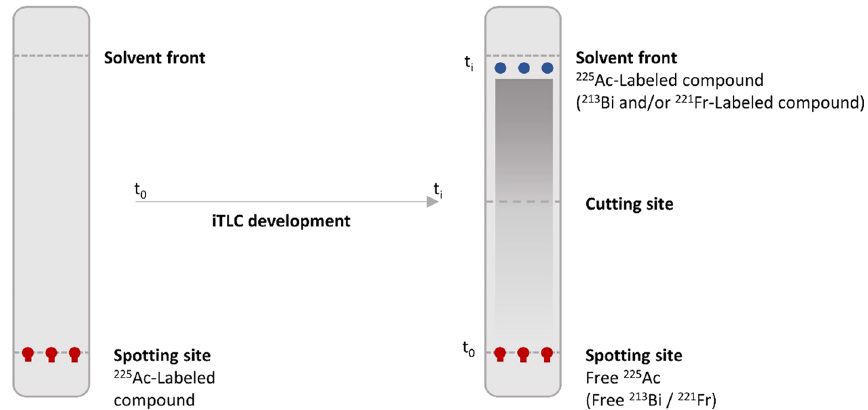
Fig. 2 Schematic representation of the migration of radiolabeled compounds in the iTLC strip. Upon exposure of the strip to the mobile phase, unbound radionuclides will remain in the spotting site, whereas bound radionuclides will move with the solvent front to the upper part of the iTLC